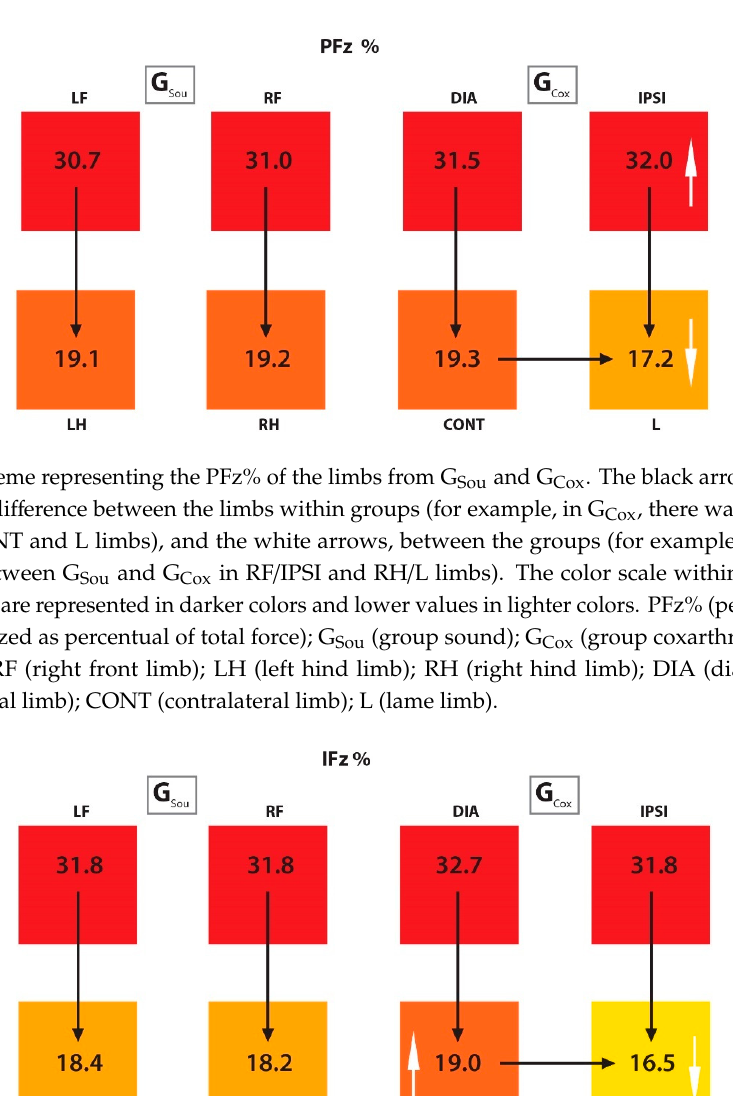
vs: “versus”. Level of significance at p < 0.05. G Sou (group sound); G Cox (group coxarthrosis); PFz% (peak of vertical force normalized as percentual of total force); IFz% (vertical impulse normalized as percentual of total force); SPD (s) (stand phase duration in seconds); TPFz% (time of occurrence of peak of vertical force as a percent of the stance phase duration); LF (left front limb); RF (right front limb); LH (left hind limb);RH (right hind limb); DIA (diagonal limb); IPSI (ipsilateral limb); CONT (contralateral limb); L (lame limb).